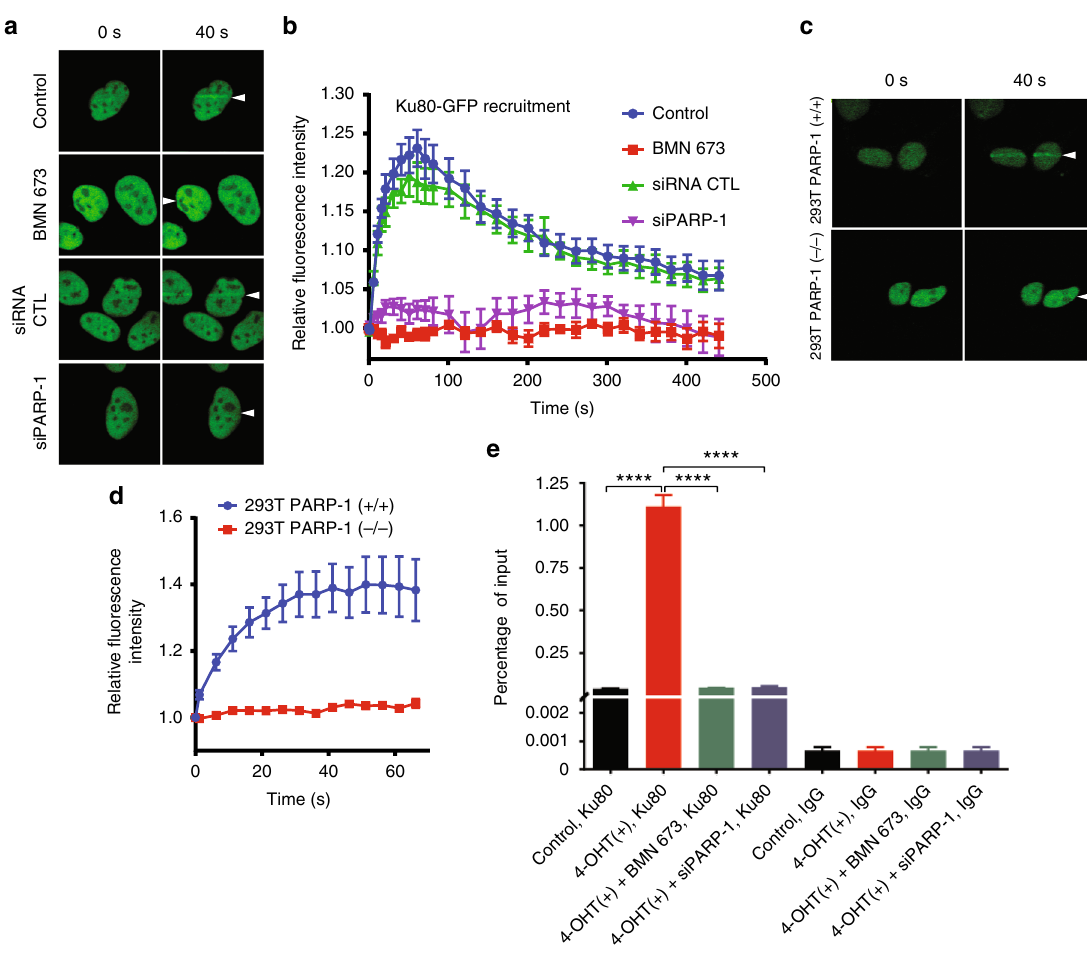
Fig. 6 Poly(ADP-ribose) polymerase-1 (PARP-1) knockdown or pharmacological inhibitor affects Ku80 recruitment on double-strand breaks. a U2OS cells stably expressing the Ku80-GFP were mock treated, treated with BMN 673, or silenced with PARP-1 siRNA and subjected to laser microirradiation-track studies. b Quanti fi cation of the relative fl uorescence intensity of Ku80-GFP over time. Error bars represent mean with s.e.m. c Recruitment of Ku80-GFP in PARP-1-de fi cient CRISPR 293T cells is severely affected. d Quanti fi cation of the relative fl uorescence intensity of Ku80-GFP over time. Error bars represent mean with s.e.m. e AsiS1-ER-U2OS reporter cells were cultured and treated with 4-hydroxytamoxifen (300 nM) for 1 h. Soluble chromatin fractions